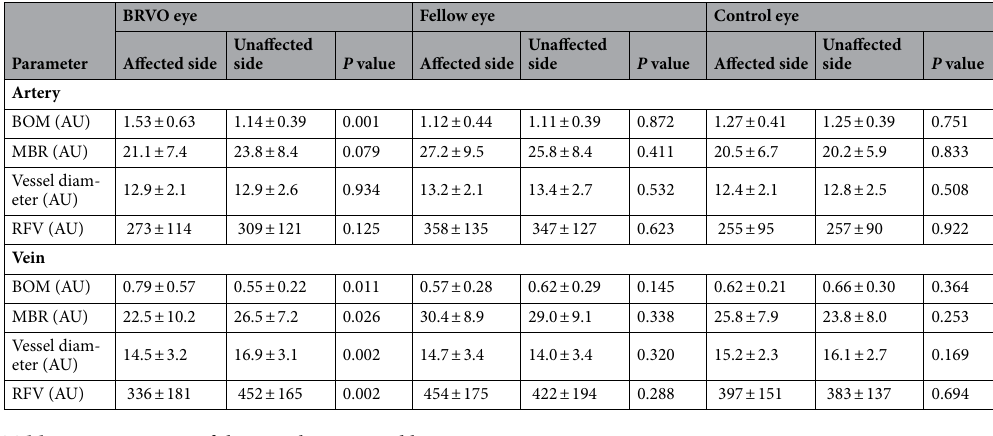
Table 2. Parameters of the vessels measured by LSFG.